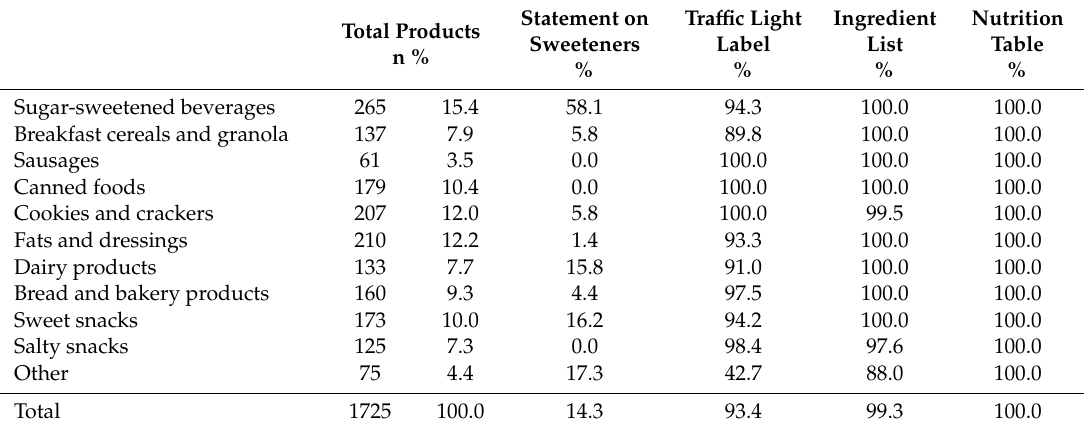
Table 2. Proportion of nutrition components found on the product label by category of food.